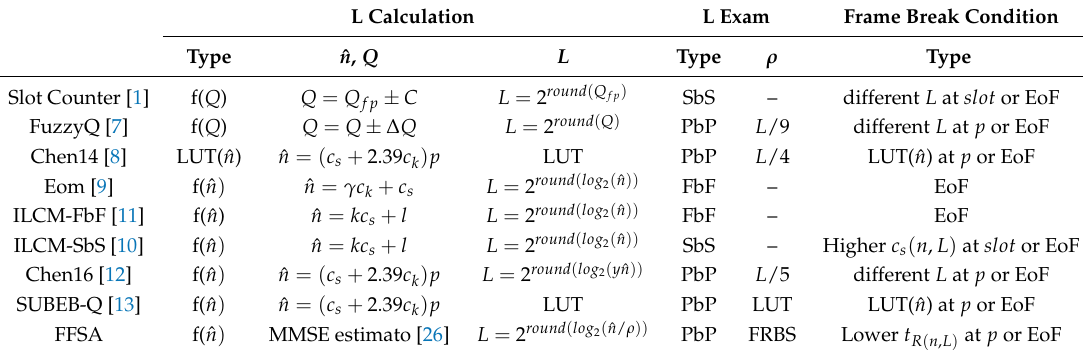
Table 2. Classification of main DFSA anti-collision protocols according to their frame update